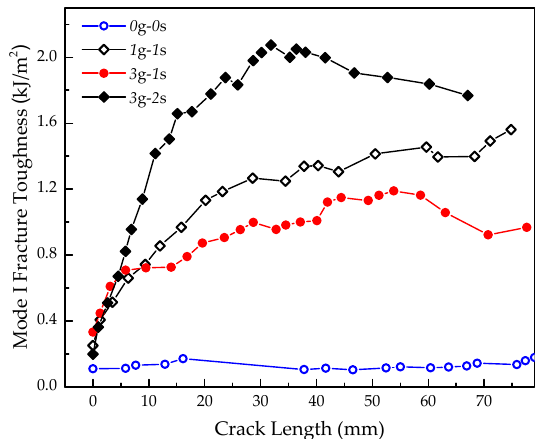
Figure 5. Representative growth resistance (R)-curves for FMLs obtained from mode I experiments. The critical initiation toughness ( (cid:1833) (cid:3010)(cid:3030),(cid:3036) ) and the steady-state (crack propagation) toughness ( (cid:1833) (cid:3010)(cid:3030),(cid:3046)(cid:3046) )